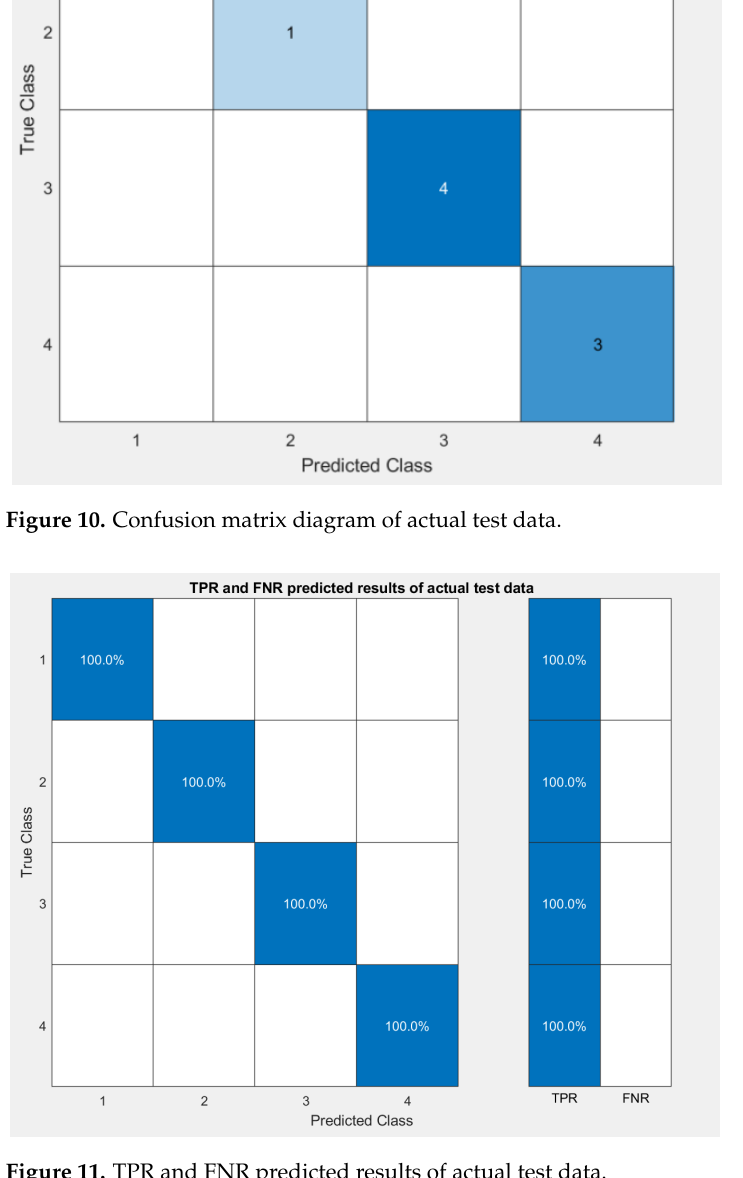
Figure 11. TPR and FNR predicted results of actual test data.